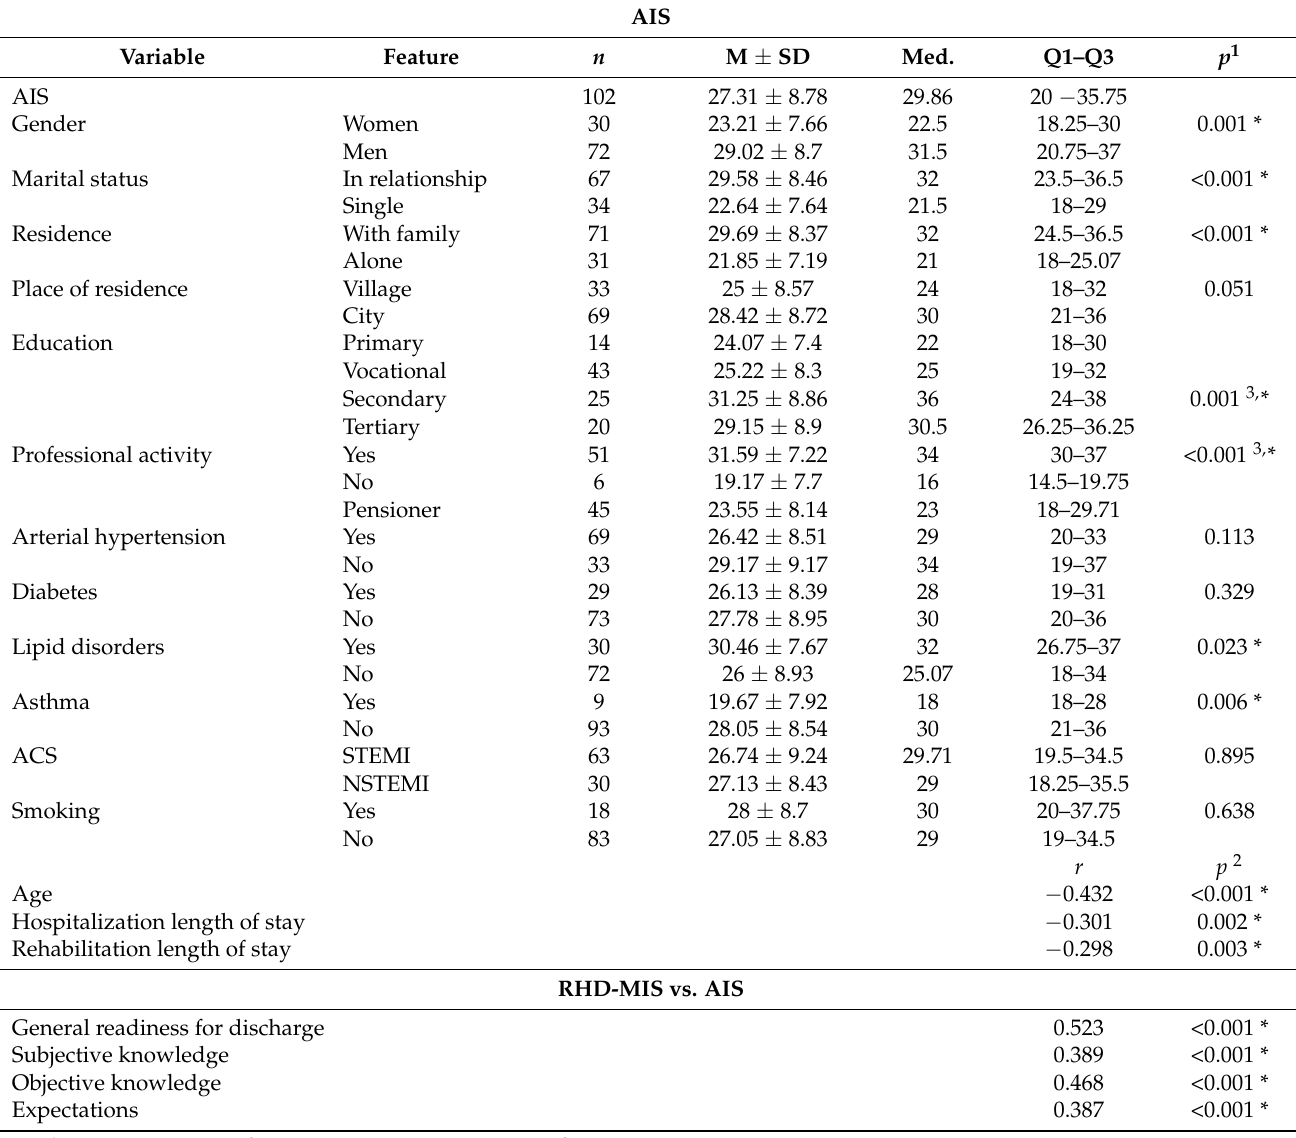
Table 6. Effects of socio-demographic and clinical variables on acceptance of illness (AIS) in patients after myocardial